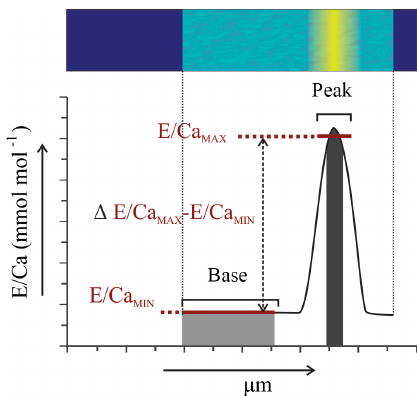
Figure 2. Illustration showing the theoretical transect map and re- sulting distribution profile with an area of selection for peak–base